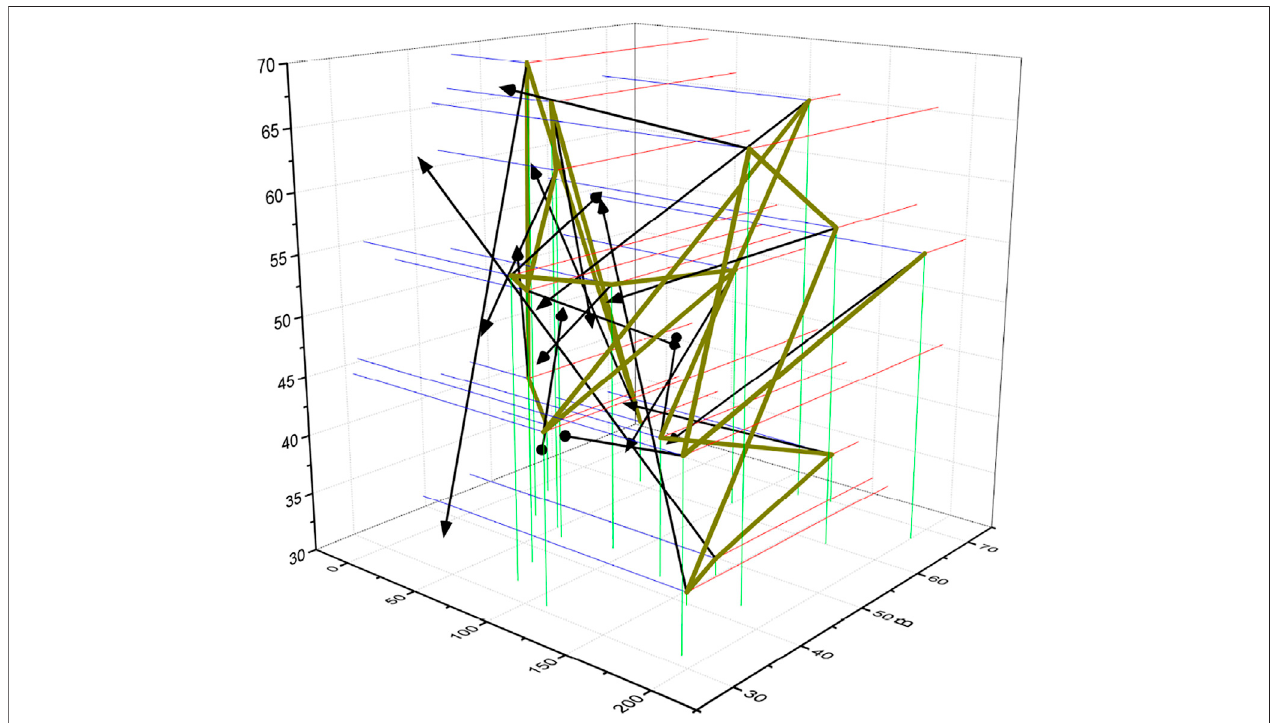
FIGURE 4 | Initial structure point column